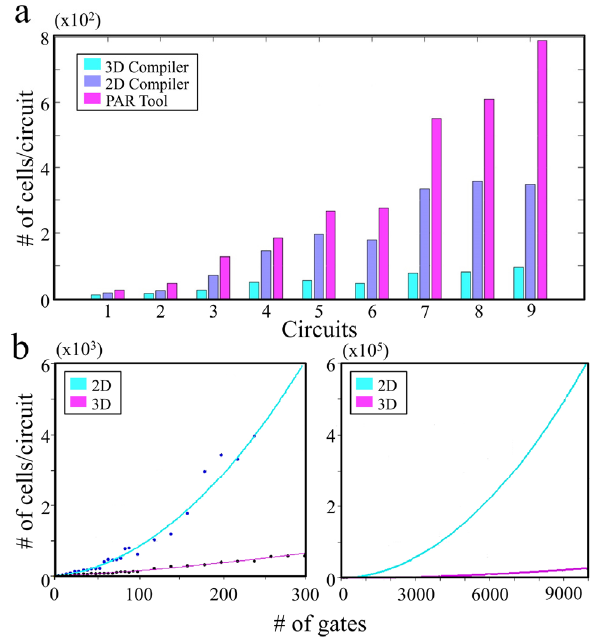
Figure 2. Simulation results for comparison of performance for 2D vs. 3D integration of gates. ( a ) 2D vs. 3D cell matrix compilers and PAR Tool (Perl Archive Toolkit) performance comparison; ( b ) comparison of the number of cells required for the same performance when the gates are integrated in 2D and